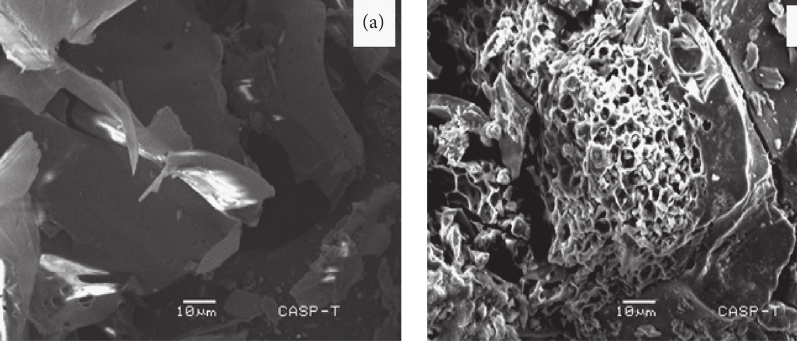
Figure 1: SEM image of (a) SB and (b) TSB at × 1000